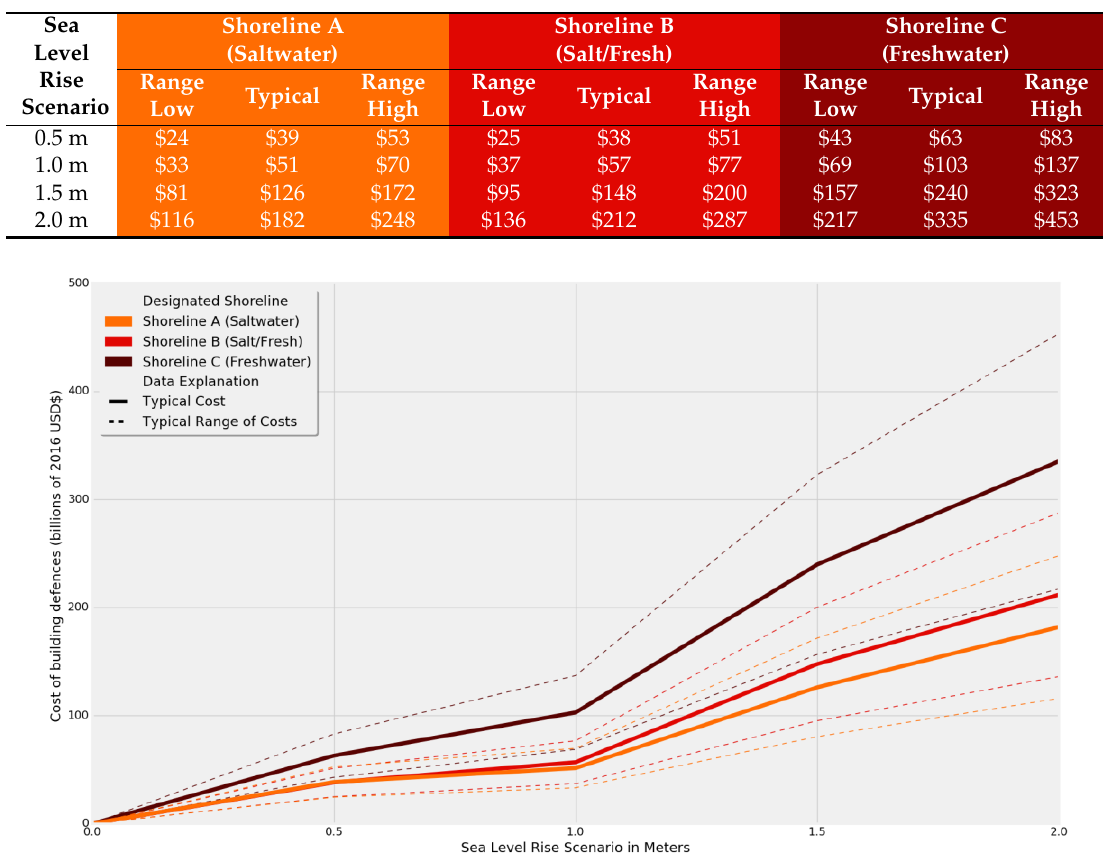
Table 5. Estimated costs for raising coastal protective infrastructure to meet future sea level rise scenarios for the three designated potential shorelines in billions of USD$.